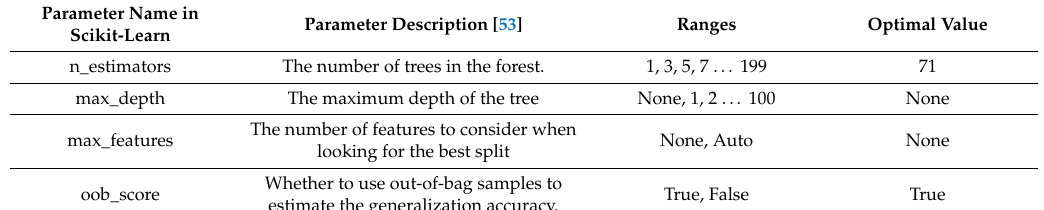
Table 4. RF model parameter list and main optimal combination of this model.